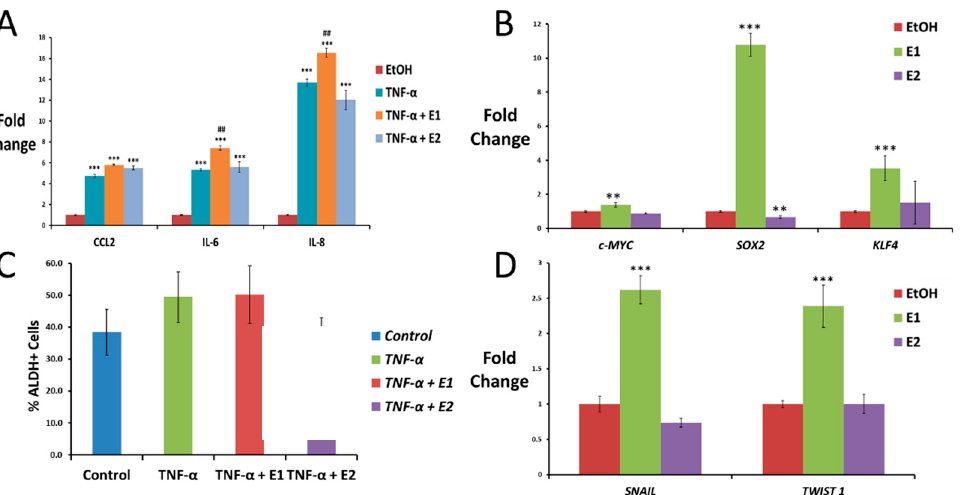
Figure 4. Effect of TNF- α , estrone and estradiol on driving inflammation, stemness and EMT in HeLa cells. ( A ) Pro-inflammatory cytokine expression measured using qPCR in HeLa cells after treatment with 10 ng/mL TNF- α for 4 h alone or in combination with 10 nM E1 or E2 (data normalized to 1 for control (EtOH) using GAPDH as the housekeeping gene). ( B ) qPCR for the expression of the ES-TF c-MYC and SOX2 in HeLa cells after 3 weeks of exposure to 10 nM E1 or E2 (data normalized to 1 for control (EtOH) using GAPDH as the housekeeping gene). ( C ) Expression of ALDH activity measured using flow cytometry in HeLa cells untreated (control) or treated with 10 ng/mL TNF- α alone or in combination with 10 nM E1 or E2 for 3 weeks. ( D ) EMT transcription factor expression measured using qPCR in HeLa cells exposed to 10 nM E1 or E2 for 3 weeks (data normalized to 1 for control using GAPDH as the housekeeping gene). All data are graphed as mean ± SEM from experiments performed in triplicates and repeated at least 3 times. ** p < 0.01 *** p < 0.001 vs control; ## p < 0.05 vs TNF- α